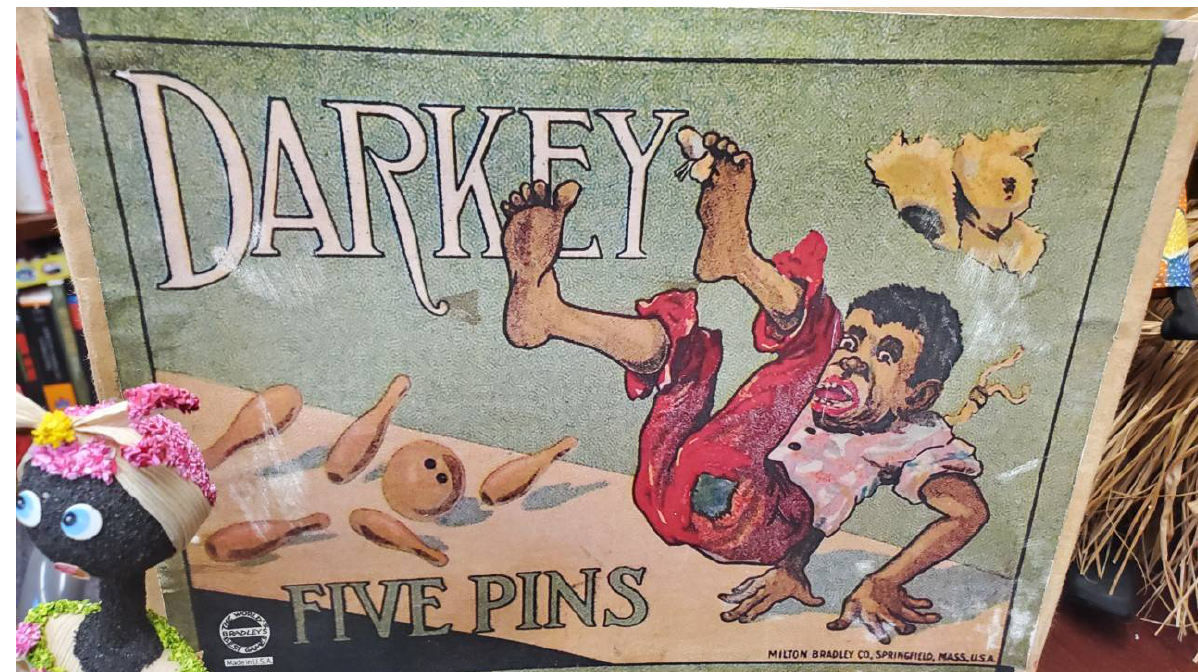
Figure 1. Early twentieth-century Darkey Five Pins is a Milton Bradley bowling game that comes with five pins that are wood-based cardboard men, each holding a watermelon. Milton Bradley also made Darkey Ten Pins [c. 1910]. Parker Brothers manufactured the similar Sambo Five Pins [c. 1920s] and a card game similar to Old Maid called The Game of Ten Little Ni-ers . Denis Mercier [n.d.] notes that various manufacturers produced numerous other such games.